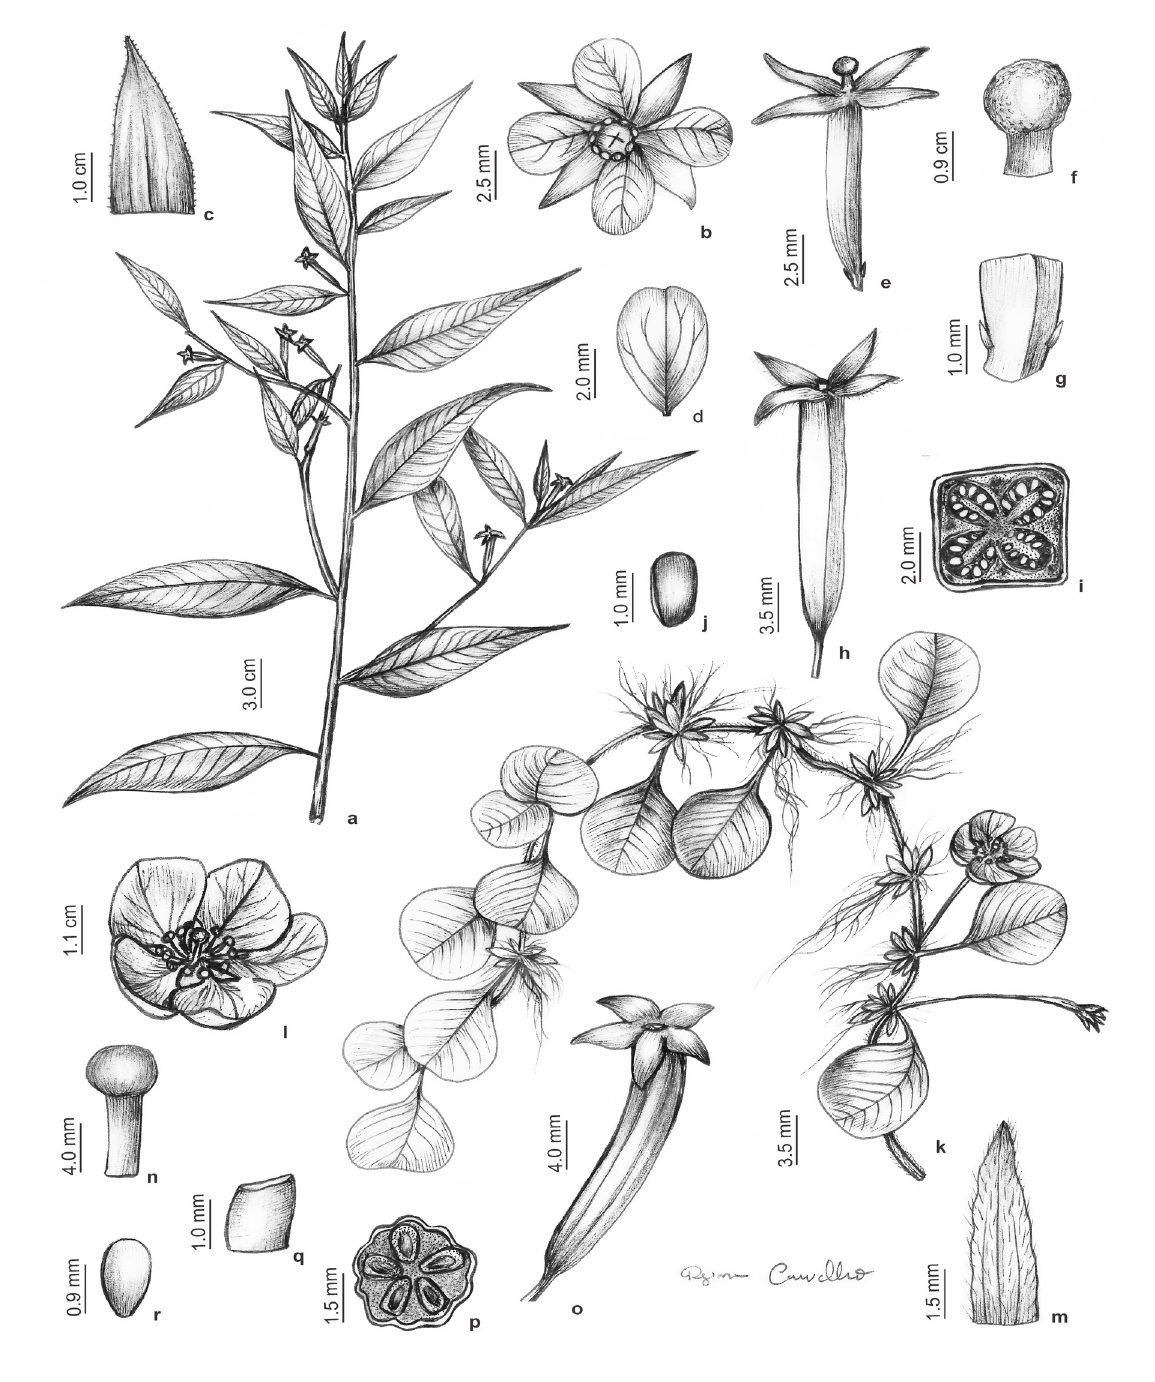
Fig. 3. a – j . Ludwigia erecta (L.) H.Hara, A.M. Rocha 26 . a . Habit. b . Flower. c . Sepal. d . Petal. e . Gynoecium. f . Detail of stigma. g . Bracteoles. h . Fruit. i . Transversal cut of the fruit. j . Seed. – k – r . L. helminthorrhiza (Mart.) H.Hara, A.M. Rocha and E.M. Rodrigues 27 . k . Habit. l . Flower. m . Sepal. n . Detail of stigma. o . Fruit. p . Transversal cut of the fruit. q . Section of the endocarp. r . Seed. Illustrations by R.M.A. de